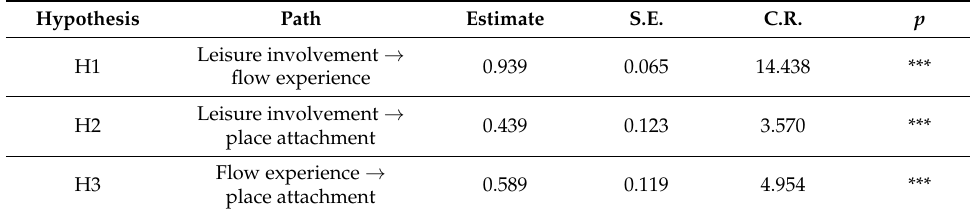
Table 5. Results of path estimation for the models.